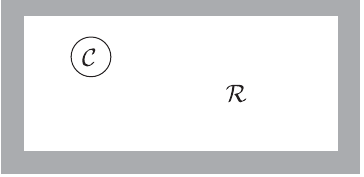
FIG. 3. Figure provided for Systems and Reservoirs